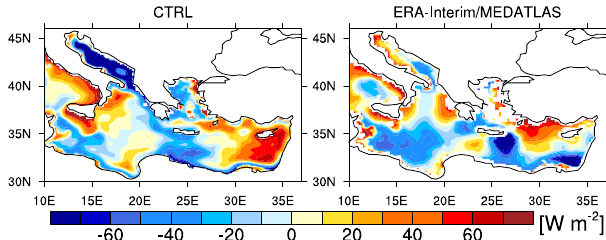
Fig. 16. Difference between the net atmospheric heat input and changes in ocean heat content from 1 May until 30 September. Left panel shows CTRL. Right panel shows differences between net at- mospheric heat input from ERA-Interim Reanalysis (averaged over 1989/2005) and changes in ocean heat content from MEDATLAS climatology. Positive values indicate that the atmospheric input is higher than the temperature change in the water column, reflecting an export of heat from this region. Negative values reflect a heat